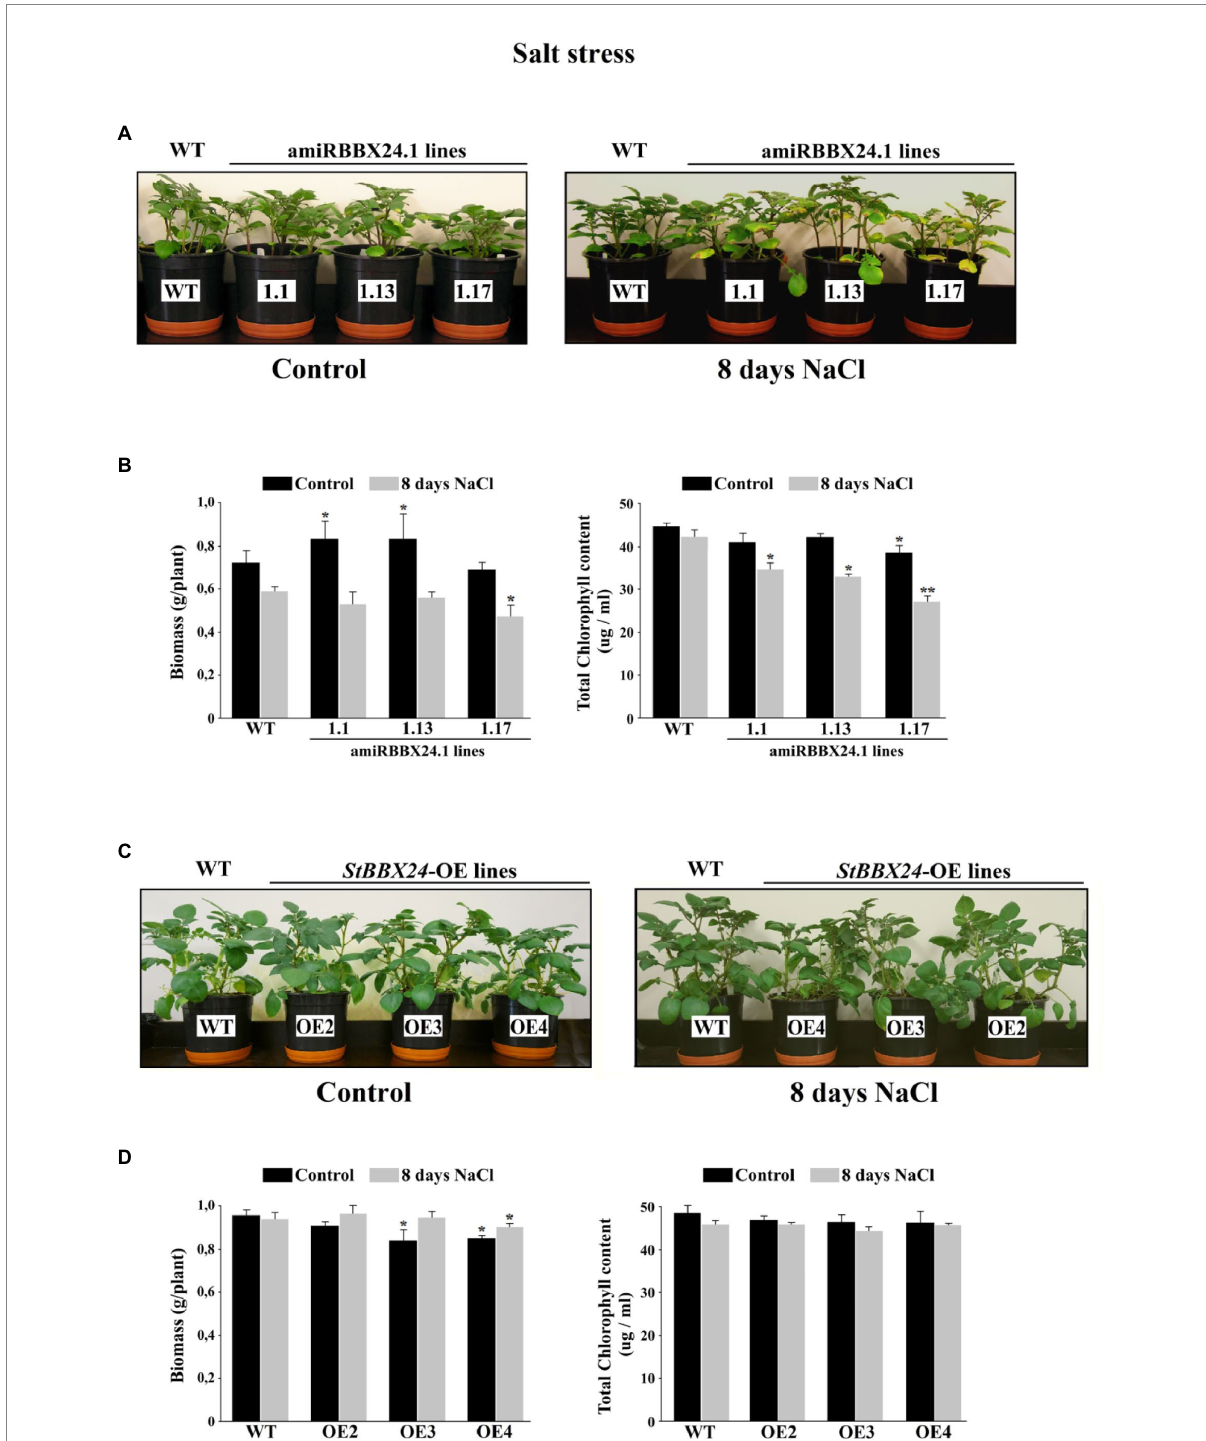
FIGURE 5 Phenotypic characterization of the StBBX24 -silenced and -overexpressing S. tuberosum lines in response to salinity. (A,C) Phenotype of phytotron-grown S. tuberosum WT, amiRBBX24.1.1, amiRBBX24.1.13 and amiRBBX24.1.17 plants, and StBBX24 -OE2, StBBX24 -OE3 and StBBX24 - OE4 lines in high salt conditions (0.15 M NaCl). Plugs from potato tubers were grown for 3-weeks in plastic pots in control conditions in a phytotron and were then watered with a solution containing 0.15 M NaCl in the same conditions for 8 days. (B,D) Biomass of aerial parts and leaf chlorophyll content of plants grown in control conditions or subjected to high salt for 8 days. Leaf biomass values are mean ± SD from 16 independent measurements per genotype. The chlorophyll content was measured using three 1-cm leaf disks from young well-expanded leaves. Statistical analysis was performed using the t -test (Statistica program, version 10). * and **, values significantly different from the WT value with p < 0.05 and p < 0.01, respectively. WT,